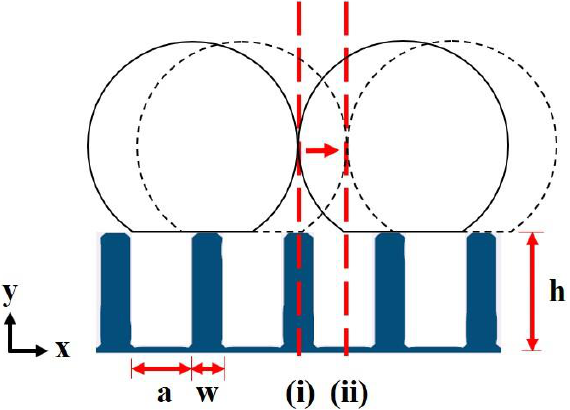
Figure 3. Schematic diagram of the periodic textured surface with flat-topped pillars (structure height h = 15 lattice, gap a = 7 lattice, pillar width w = 3 lattice). The initial position of the droplet pair is indicated by the mutual tangent of two droplets (red dotted line). The mutual tangent line is initialized from position (i) to (ii) in different cases.